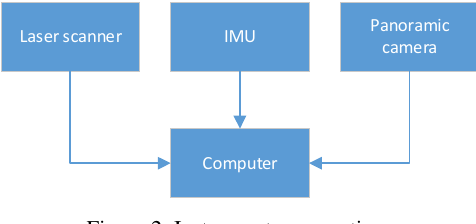
Figure 2. Instruments connections